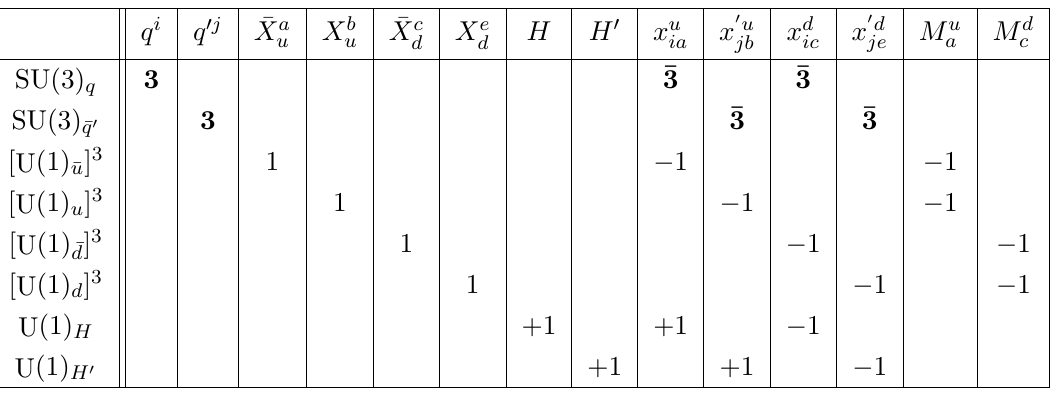
Table 7 . Spurious symmetry of the interaction in eq.